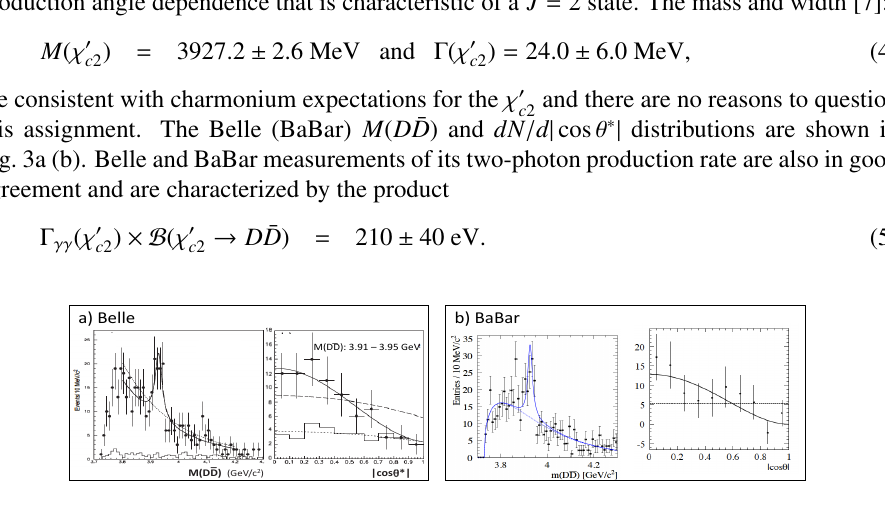
BaBar’s J PC = 0 ++ assignment for the X (3915) was based on a comparison to a 2